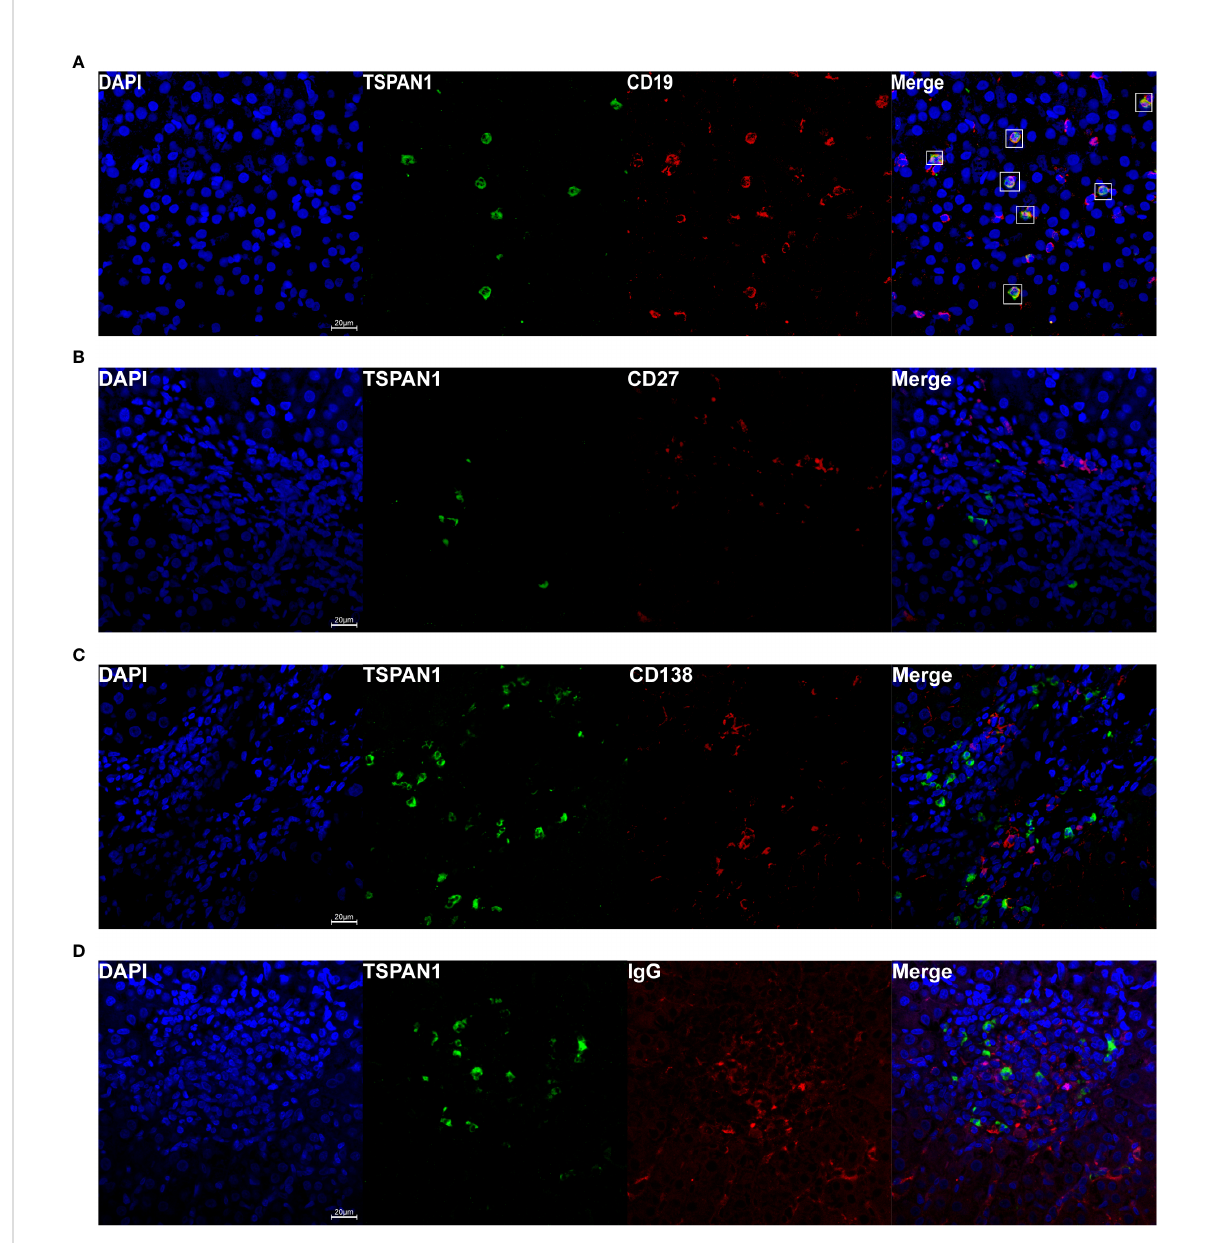
FIGURE 3 Immuno fl uorescence double-staining of CD19, CD27, CD138, and IgG with TSPAN1. Representative confocal staining of TSPAN1 with CD19 (A) , CD27 (B) , CD138 (C) , and IgG (D) (×400) in liver tissues of AIH